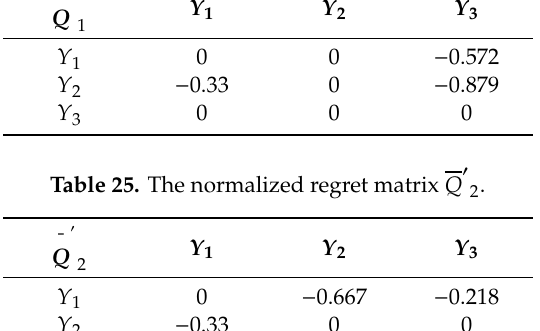
Table 24. The normalized regret matrix Q